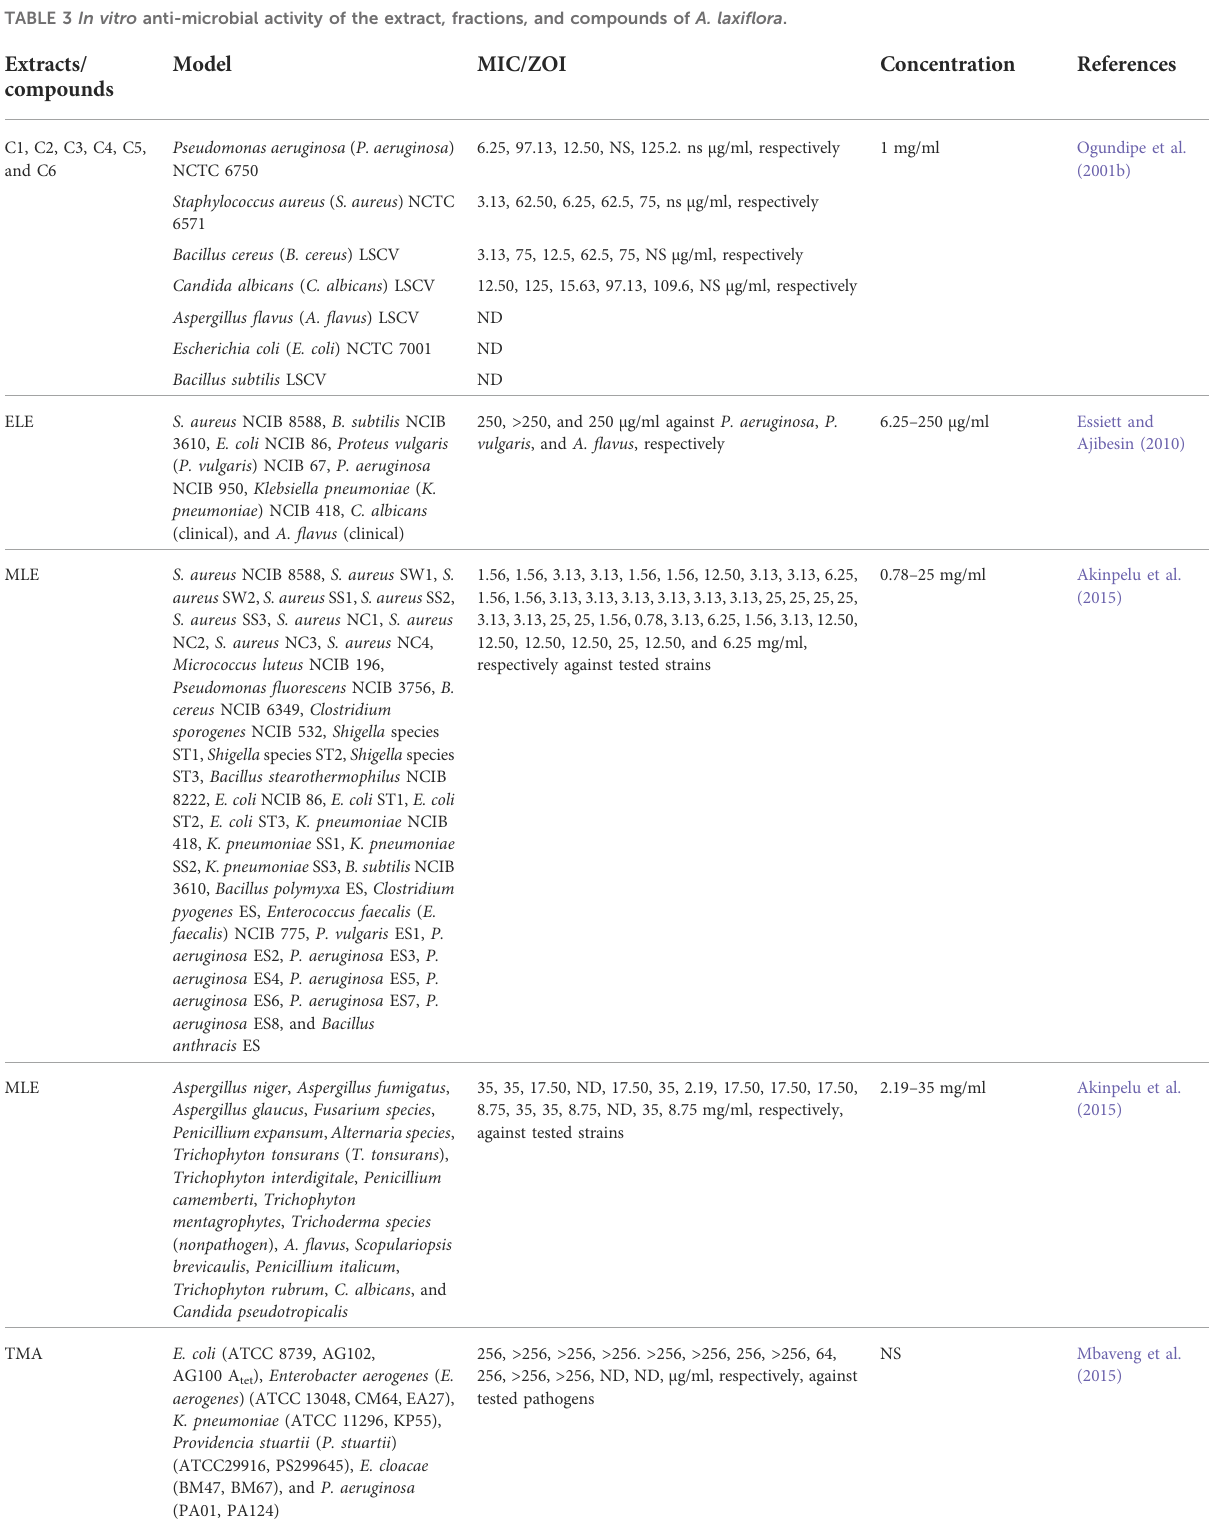
TABLE 3 In vitro anti-microbial activity of the extract, fractions, and compounds of A. laxi fl ora . Extracts/